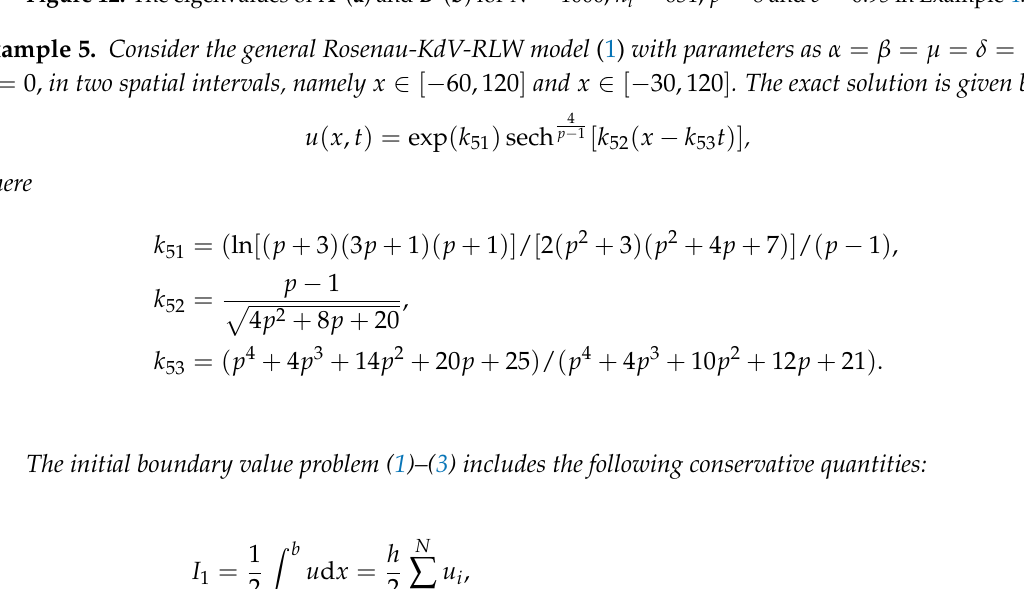
Figure 12. The eigenvalues of A ( a ) and B ( b ) for N = 1000, n i = 631, p = 8 and c = 0.95 in Example